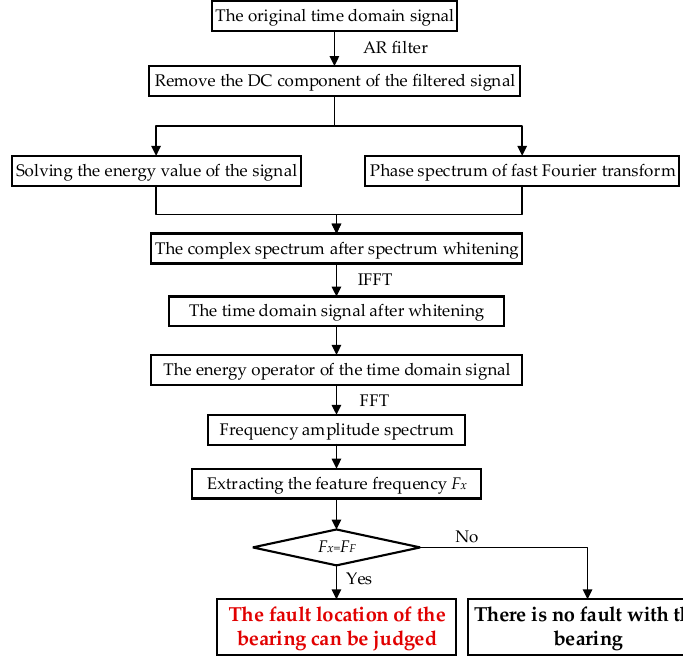
Figure 4. Flow chart of fault diagnosis.